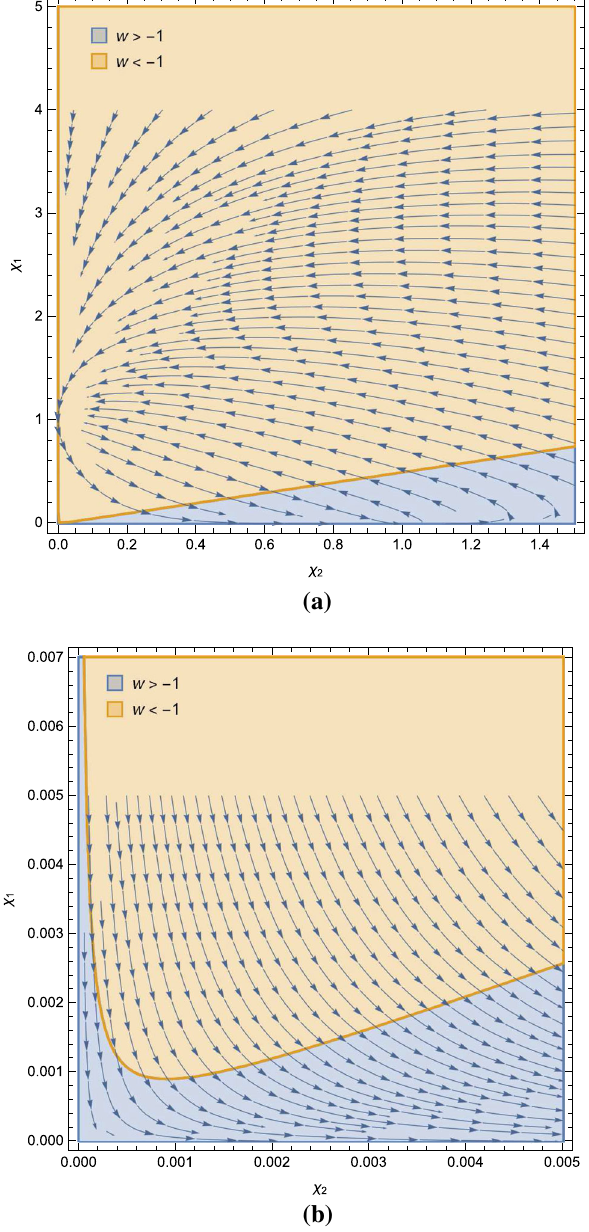
Fig. 5 These two plots show the phase portrait of the dynamical vari- ables χ 1 , 2 at two different scales. The Phantom and ordinary regions have been indicated by colors